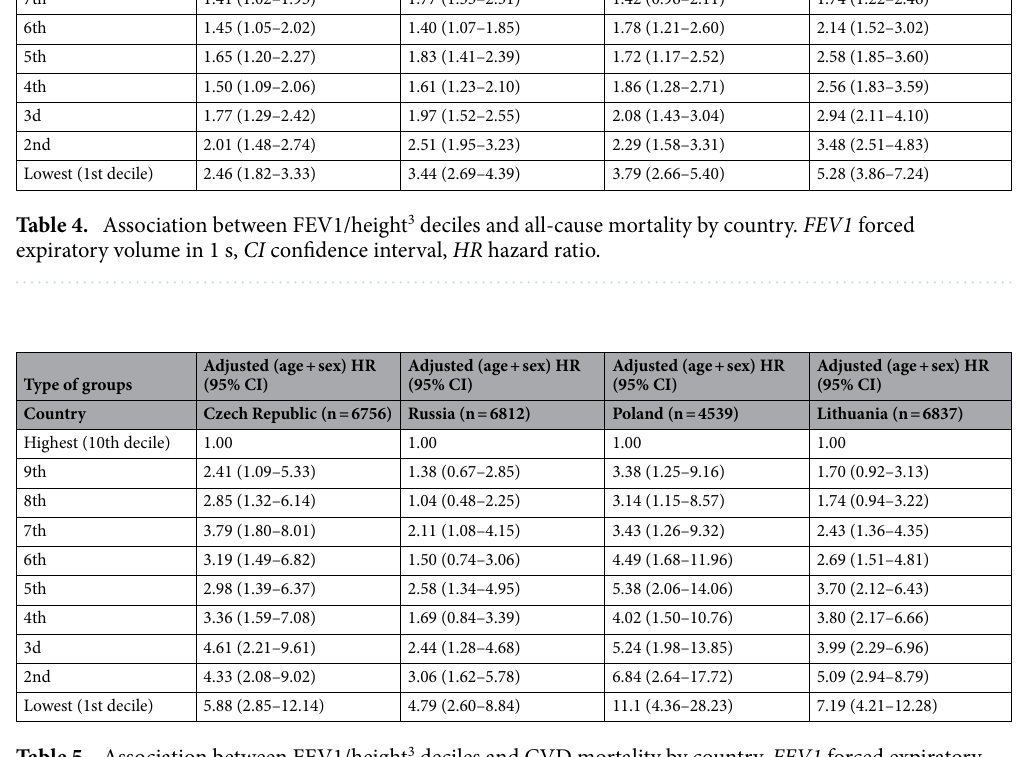
Table 5. Association between FEV1/height 3 deciles and CVD mortality by country. FEV1 forced expiratory volume in 1 s, CI confidence interval, HR hazard